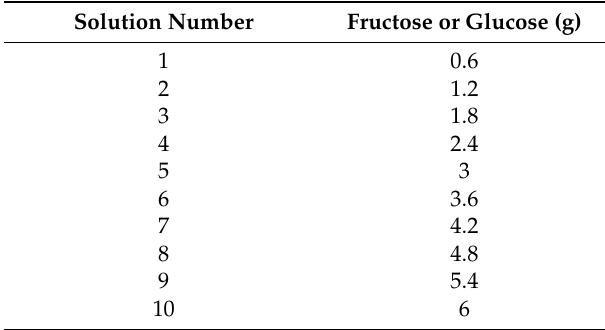
Table 1. Amount of fructose/ glucose in solutions containing 4 mL of distilled